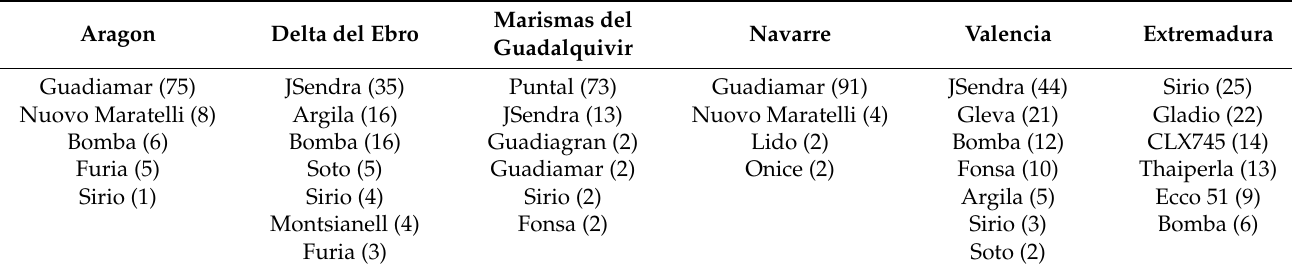
Table 2. The main rice varieties cultivated in each of the six Spanish rice areas, including in brackets their cultivated % among the rest of the varieties in the same area.